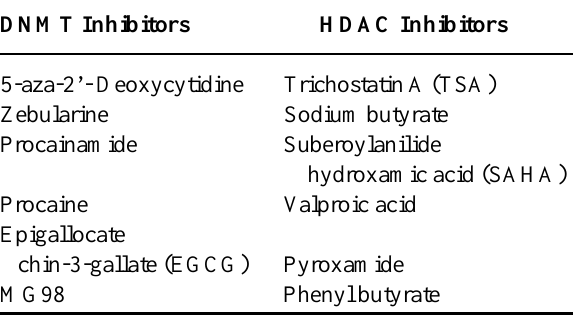
Table 3 – Drugs used for epigenetic modifications (9,32).